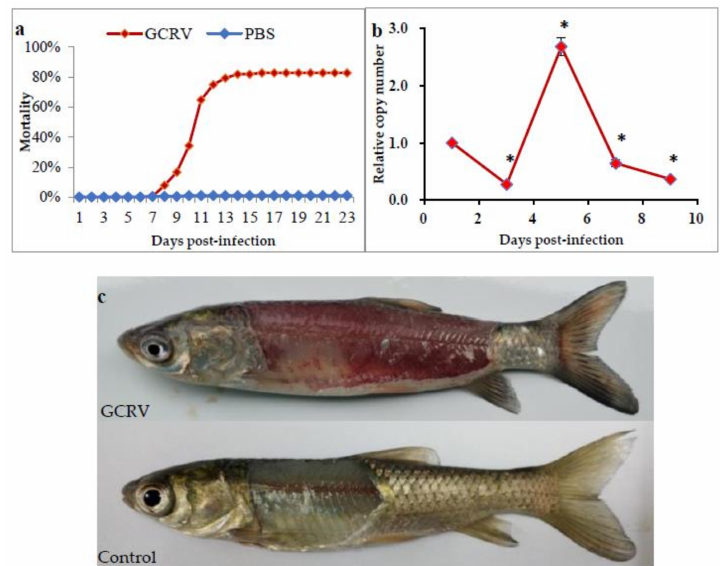
Figure 1. The fish after grass carp reovirus (GCRV) infection. ( a ) Cumulative mortality of fish. Fish were infected with 200 µ L GCRV or PBS by intraperitoneal injection, respectively. The number of dead fish in each group was counted every day until no deaths were recorded for seven consecutive days. ( b ) Relative copy number of GCRV in infected fish. Data represent mean ± standard deviation of three replicates. Significant difference ( p < 0.05) is indicated with asterisks (*). ( c ) The clinical symptom of fish after GCRV infection.